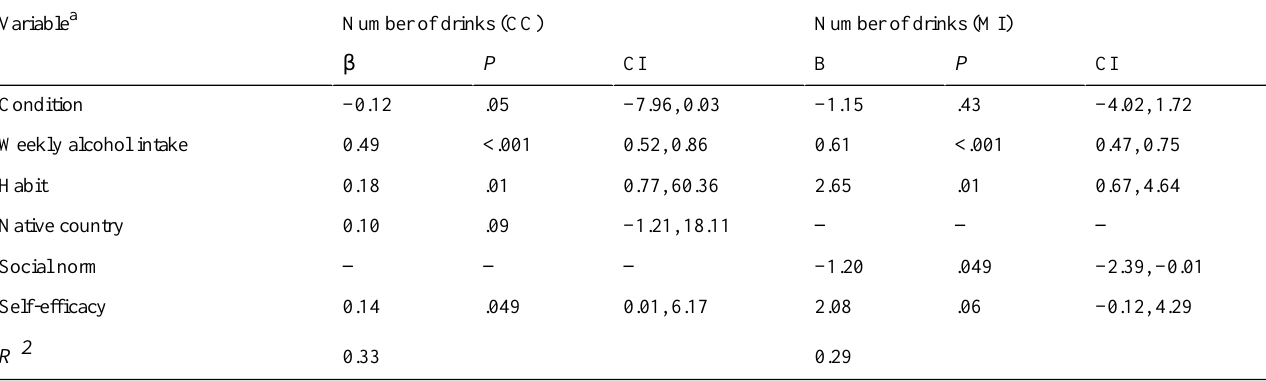
Table 3. Results of the linear regression analysis (backward method) with the number of alcoholic drinks after 6 months as dependent variable among complete cases (CC, n=197) and after applying multiple imputations (MI, n=448).